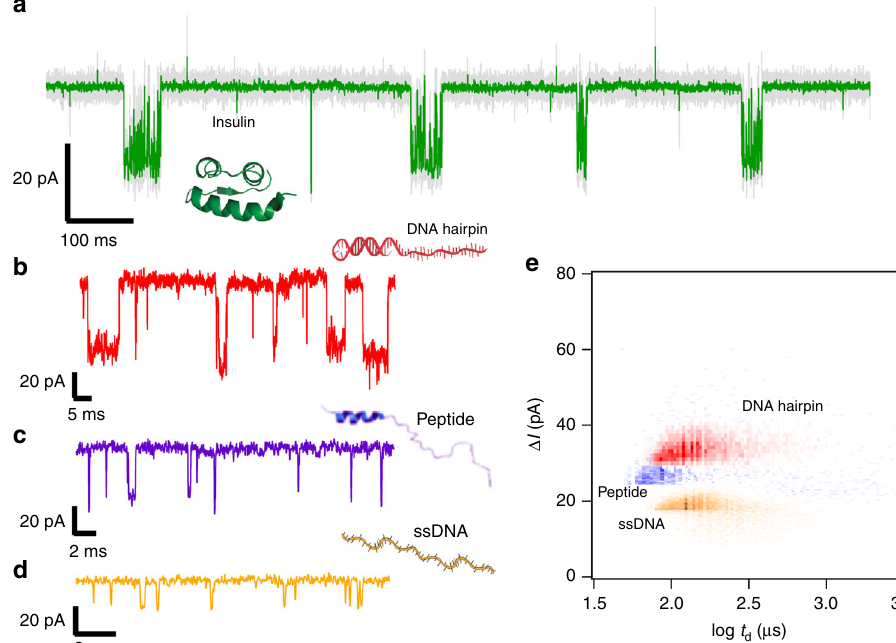
Fig. 4 Sensing different biopolymers using a hybrid nanopore. Current vs time trace recorded through the hybrid pore at + 60 mV in the presence of a 36.0 μ M insulin, b 7.7 μ M DNA hairpin, c 10.3 μ M TPX2 peptide and d 16.6 μ M ssDNA. The data in a were fi ltered at 10 kHz (gray) or 0.5 kHz (green). e Scatter plot of Δ I vs dwell time for the DNA hairpin (red, n = 5883 events), the peptide (purple, n = 3368 events) and the ssDNA (orange, n = 18,812 events)). Experiments were performed in 0.5 M NaCl, 20 mM Tris, pH 7.5